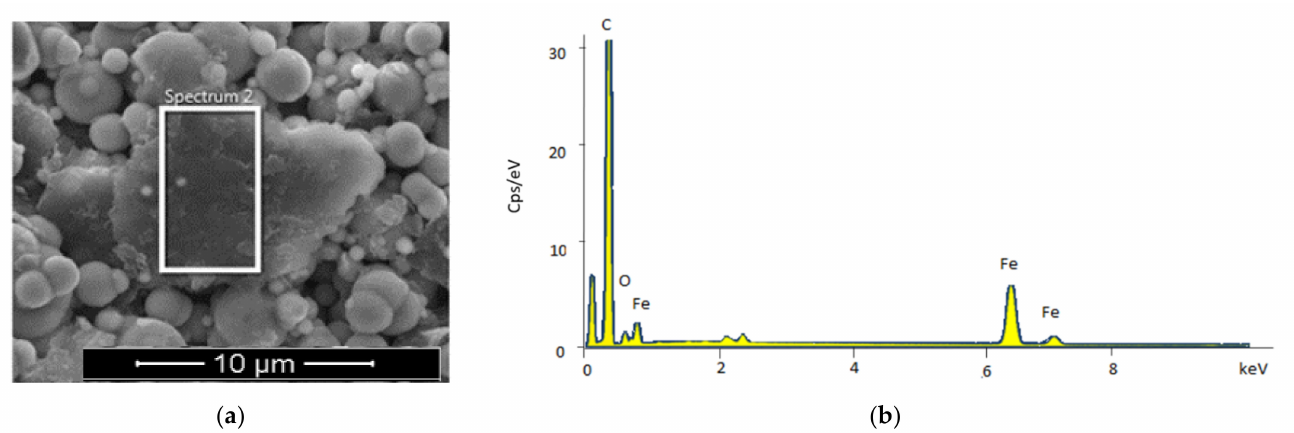
Figure 4. ESEM image of Gr–MRP sample with selected microstructure area ( a ) and the EDX observation of the Gr–MRP sample ( b